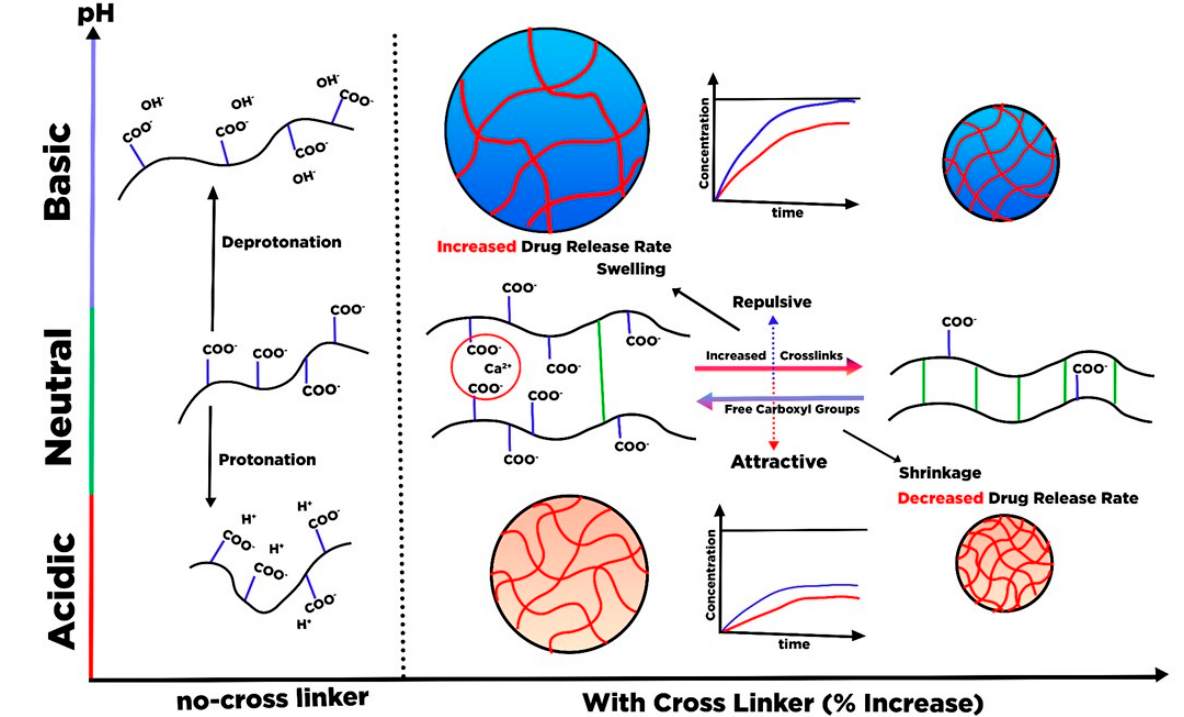
Figure 13. Schematic illustration of the swelling mechanism of hydrogel fabricated from TEMPO-mediated CNFs and alginate towards drug release (this figure is redrawn from [181]. Copyright © 2020 Elsevier B.V.).